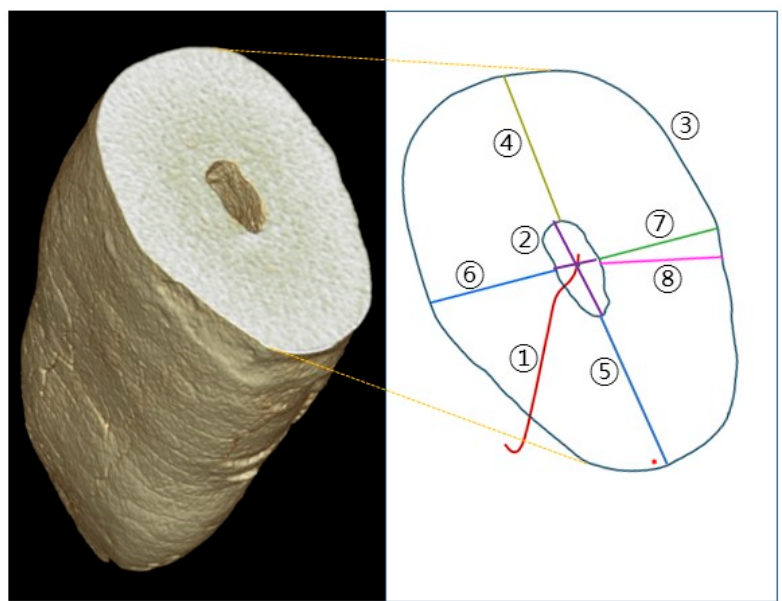
Figure 3. Graphical visualization of the measurements. Left image is the representative 3D root model, and the right image is its section; ① the central axis (red curve) of the canal; ② the root canal; ③ root outline; ④ labial dentin thickness; ⑤ lingual dentin thickness; ⑥ mesial dentin thickness; ⑦ distal dentin thickness; ⑧ the thinnest dentin thickness and its direction.